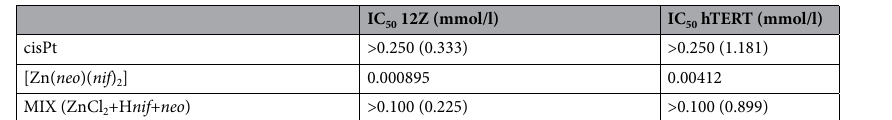
Table 2. IC 50 calculated from CI at a time point (72 h) versus concentration 79. The values of IC5 0 of the complex ([Zn( neo )( nif ) 2 ]), cis-platin ( cis Pt), and the mixture of the complex components (MIX=ZnCl 2 +H nif + neo ). *Values in the brackets represent calculated IC 50 values based on